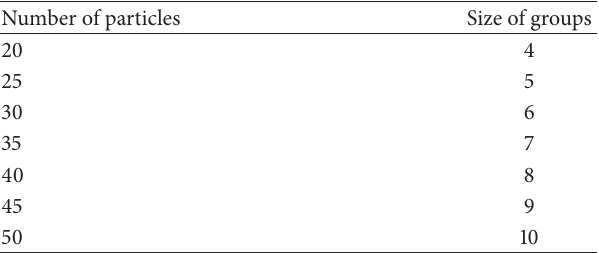
Table 6: Experimental setup for size of groups.